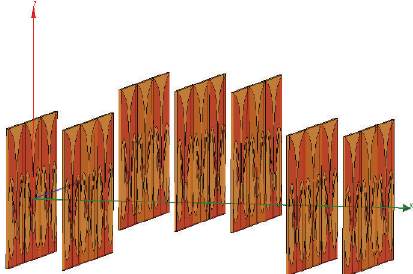
Figure 9: 3 × 7 unit ladder